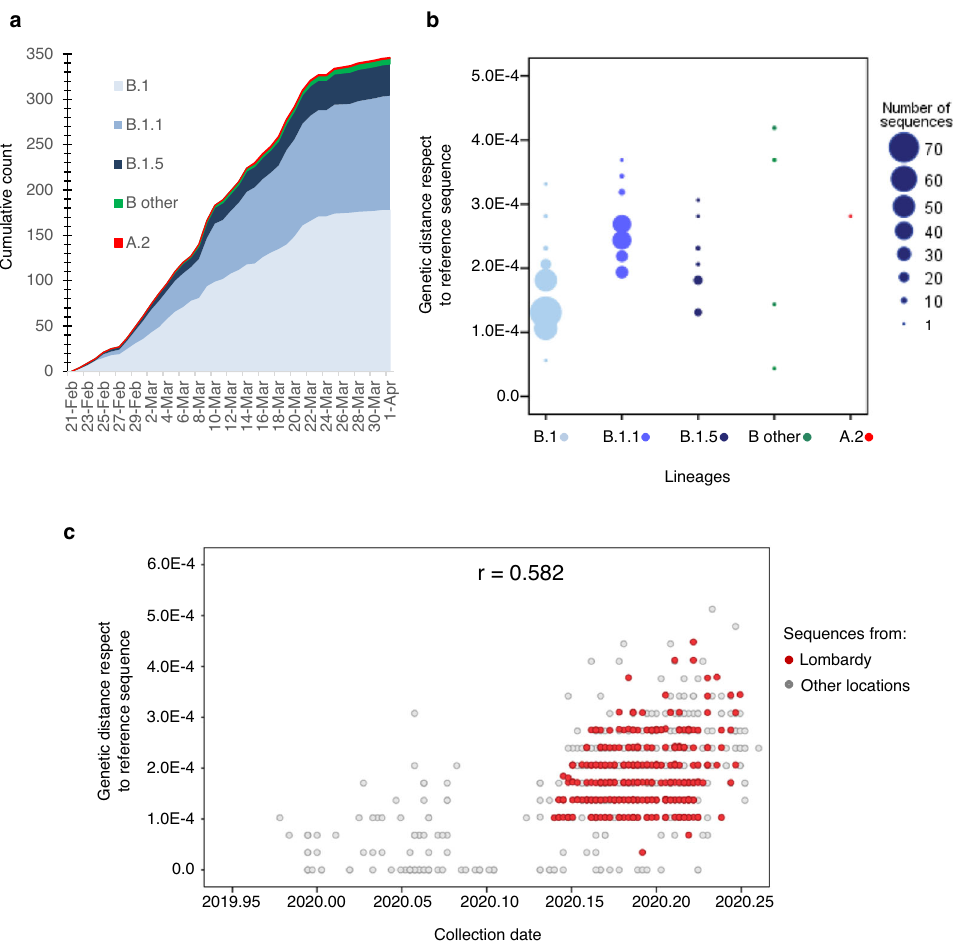
Fig. 3 Distribution of SARS-CoV-2 genomes against lineages and collection date. a Cumulative counts of the 346 SARS-Cov-2 genomes circulating in Lombardy against collection date. b Genetic distance for the Sars-Cov-2 genomes circulating in Lombardy against lineages. c Genetic distance for the Sars- Cov-2 genomes against collection date. The Pearson correlation coef fi cient between genetic distance and collection date is displayed in the top-right corner ( r = 0.582). Sequences are colored by sampling location (Lombardy = red, other location = gray). Reference sequence: NC_045512.2. ‘ B other ’ refers to haplotypes B, B.1.1.1, and